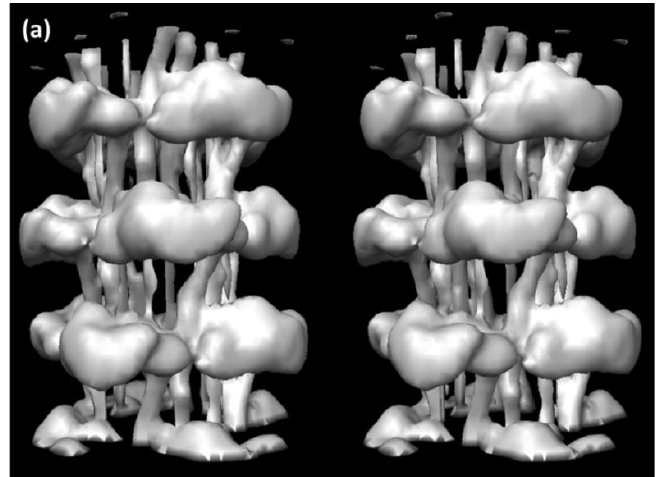
Figure 7. Part of the 3D reconstruction of the insect flight muscle myosin filament according to Hu et al. [27], here showing slightly more than three crowns as a stereo (wall-eyed) surface